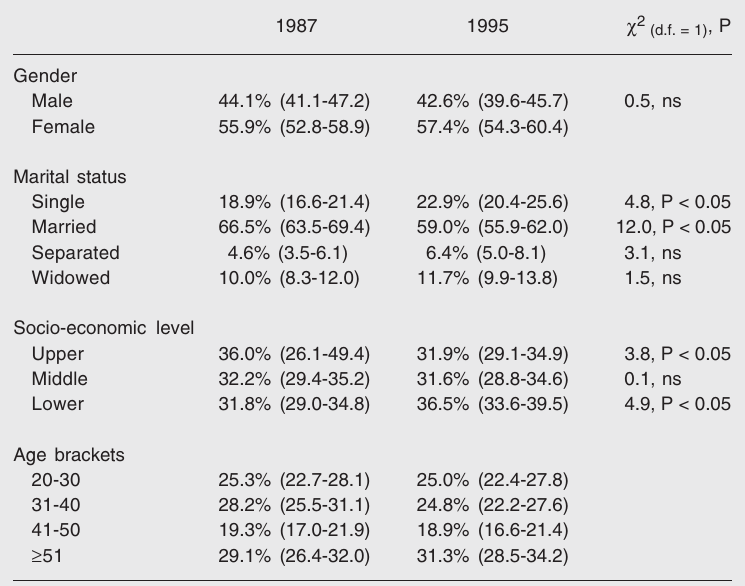
Table 1. Socio-demographic characteristics of the study population.